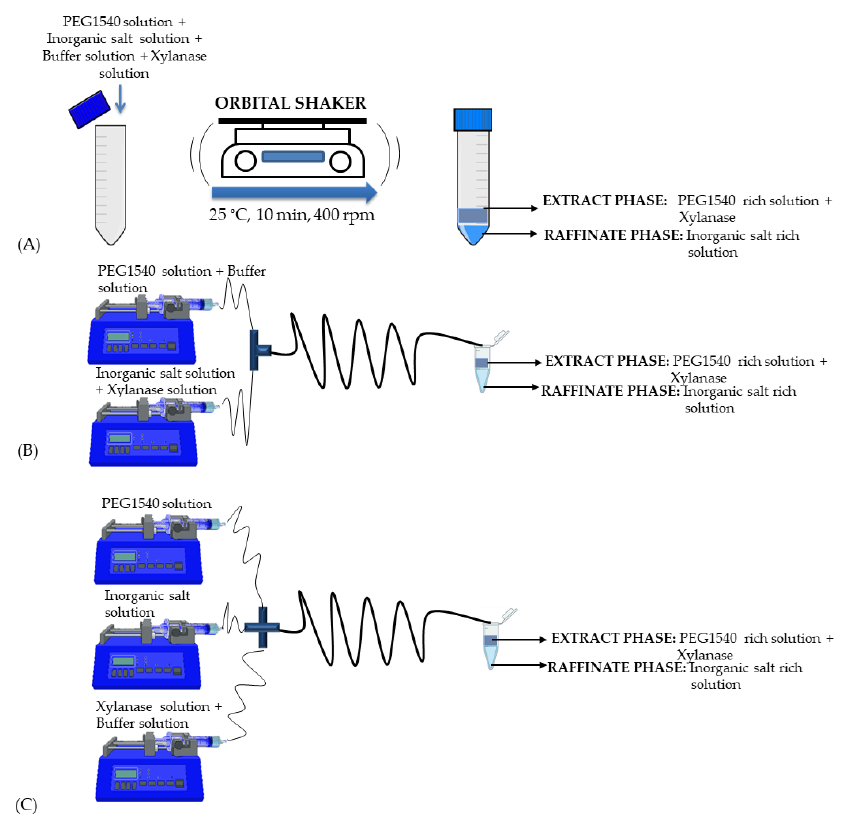
Figure 1. Schemes of the experimental set-ups used for xylanase extraction in a ( A ) batch, ( B ) mi ‐ croextractor with two inlets, and ( C ) microextractor with three inlets.